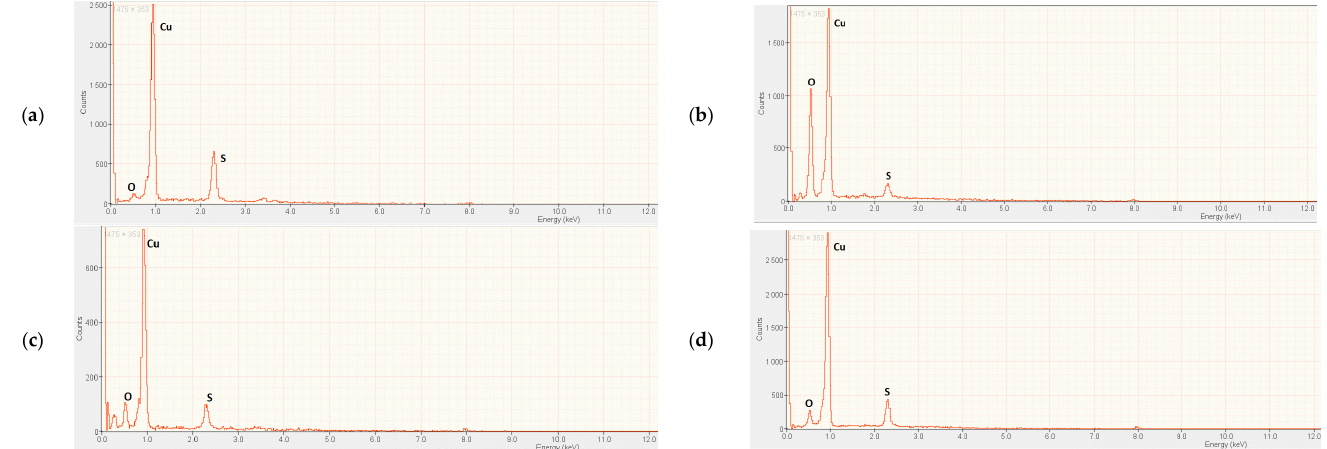
Figure 16. EDS spectra for CuSn6 bronze: ( a ) initial state; ( b ) after continuous immersion (pH 5); ( c ) after continuous immersion (pH 6.5); ( d ) after alternating wet/dry cycles at pH 6.5.